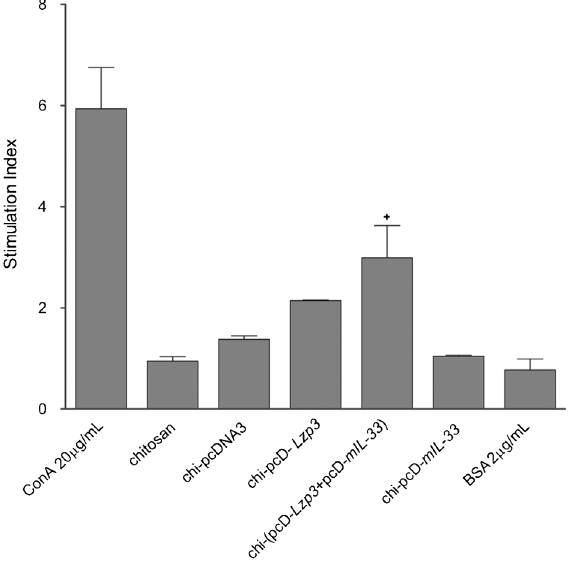
Figure 7. T cell proliferation in spleens of ICR mice immunized intranasally with different chitosan-DNA nanoparticles. Spleens were isolated from the vaccinated mice (n=3/group) on day 7 after the last immunization. Single cell suspensions were prepared and stimulated in vitro with LZP3 protein, BSA and ConA, separately. T cell proliferation was determined by the MTT colorimetric method. + P , 0.05, stimulation index of mice co-immunized with chi-(pcD- Lzp3 +pcD- mIL-33 ) compared to mice immunized with chitosan, chi-pcDNA3, and chi-pcD- mIL-33 (one-way